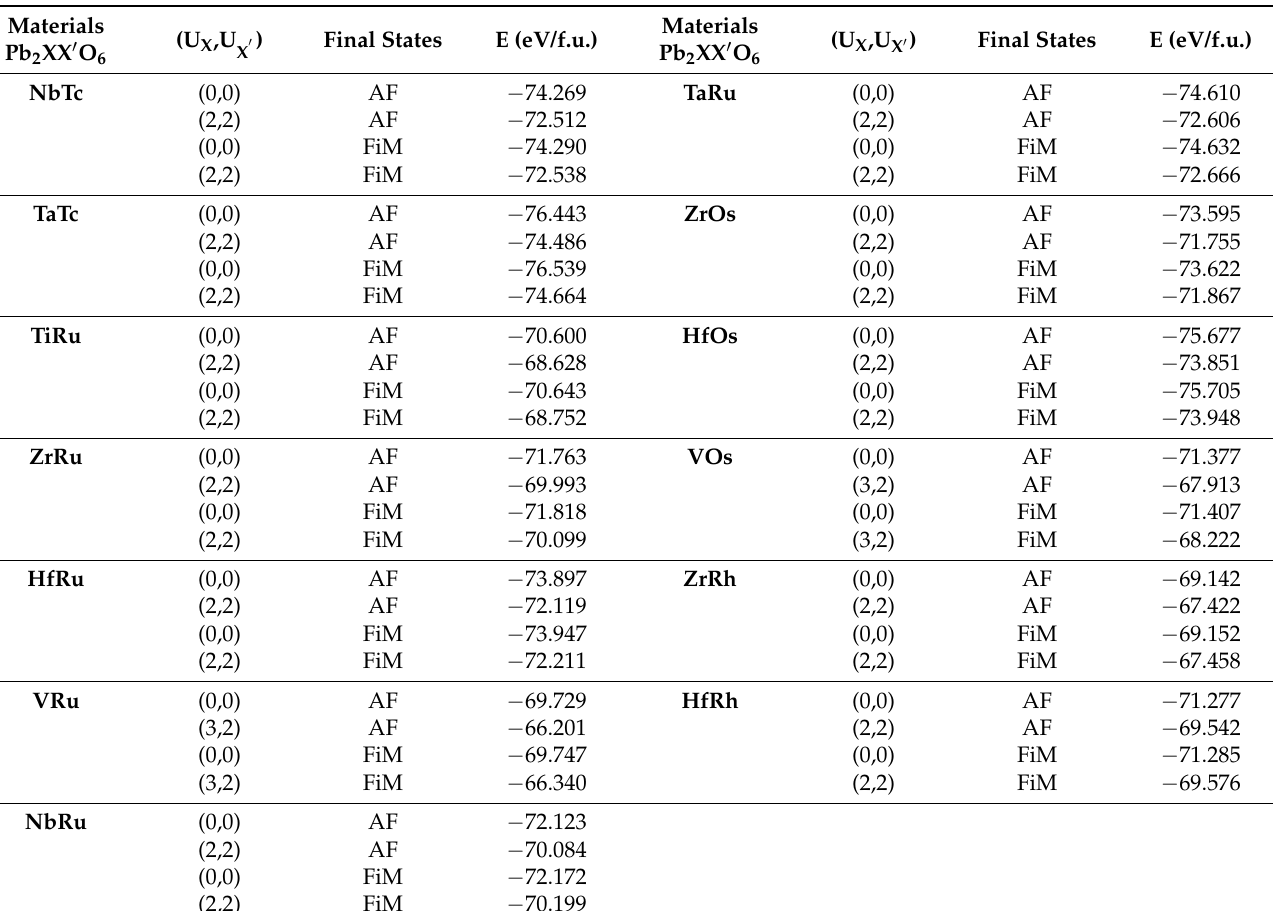
Table 2. In the table below, total energy of possible HM candidates with each magnetic state is presented. U X(X (cid:48) ) are the effective parameters used in GGA + U calculations for X(X (cid:48)